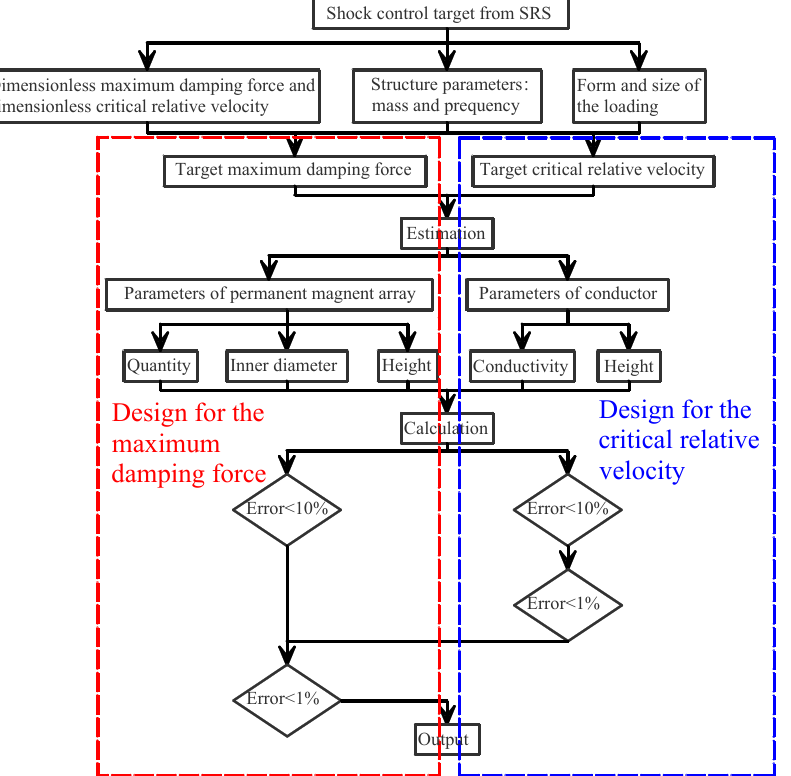
Figure 13. Design flow chart for the TLECD. Table 3. Physical parameters of a design case.